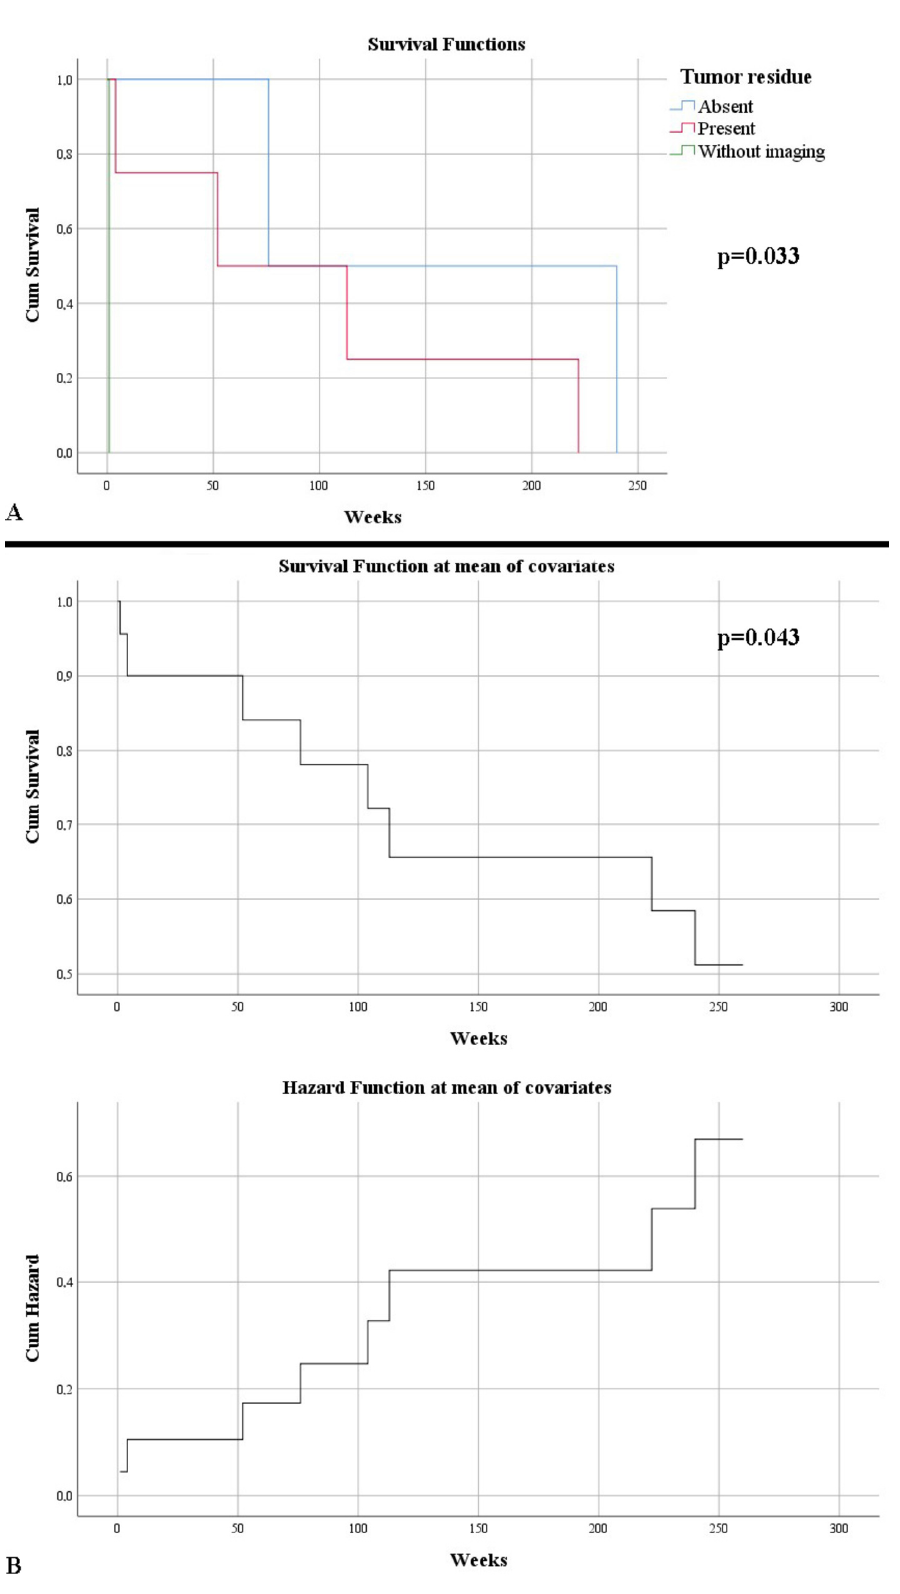
Figure 4. ( A ) Kaplan–Meier survival graphic that shows a lower survival rate in the presence of tumor residue. ( B ) Univariate Cox regression analysis that expresses the risk of death in the presence of a tumor residue.